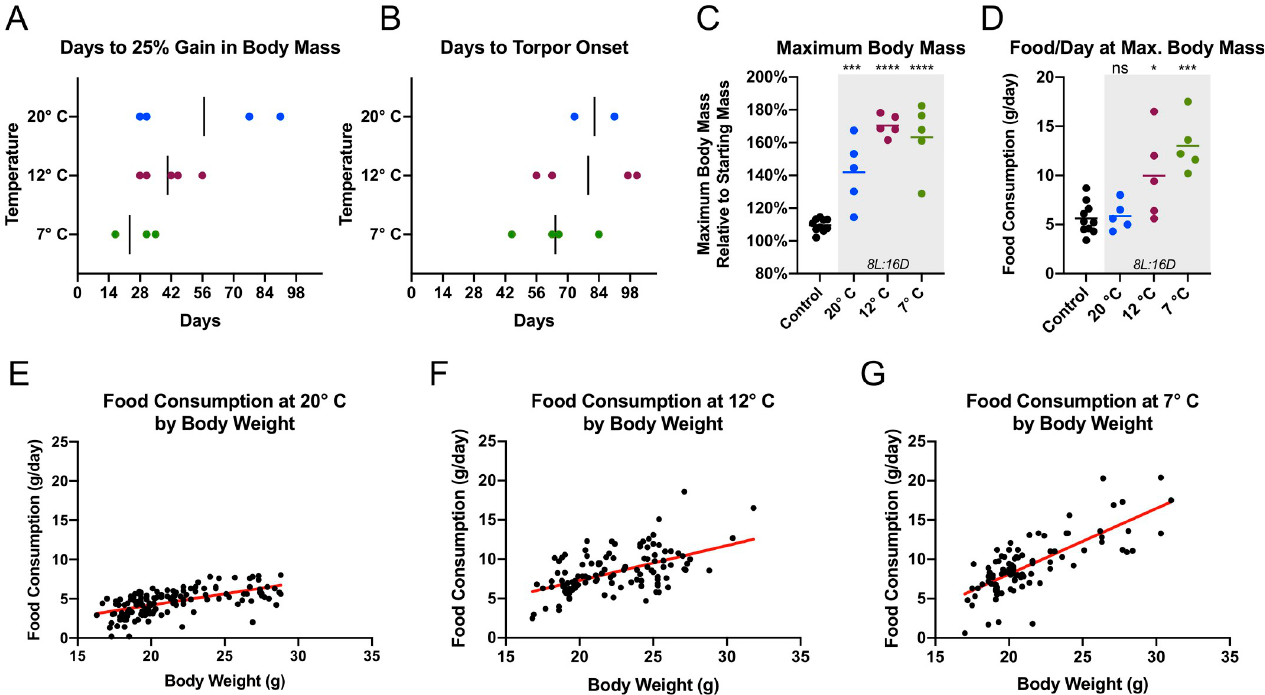
Fig 5. Ambient temperature affects pre-hibernation weight gain and food consumption in captive meadow jumping mice. Captive-reared meadow jumping mice in hibernation induction conditions (8L:16D and 20˚C, 12˚C, or 7˚C) show trends toward earlier weight gain ( A ) and earlier onset of torpor ( B ) at lower temperatures. ( C ) Maximum attained body mass is significantly increased in all hibernation induction conditions (shaded gray) versus controls. Means differed significantly by ANOVA ( F = 30.92, p < 0.0001) and asterisks indicate adjusted p -values from Dunnett’s multiple comparisons test between control and each induction condition: 20˚C ( p = 0.0007), 12˚C ( p < 0.0001), and 7˚C ( p < 0.0001). ( D ) Daily food consumption at maximum attained body mass is significantly increased at 7˚ C and 12˚ C, but not 20˚C. Induction conditions are shaded gray. Means differed significantly by ANOVA ( F = 11.10, p = 0.0001) and asterisks or ‘ns’ (not significant) indicate adjusted p -values from Dunnett’s multiple comparisons test between control and each induction condition: 20˚C ( p = 0.9964), 12˚C ( p = 0.0166), and 7˚C ( p = 0.0001) ( E-G ) The relationship between body weight and food consumption is shown at 20˚C (panel E ), 12˚ C (panel F ), and 7˚C (panel G ). Red best fit lines increase in slope as temperature falls, illustrating the interaction between body mass and temperature with respect to food consumption.